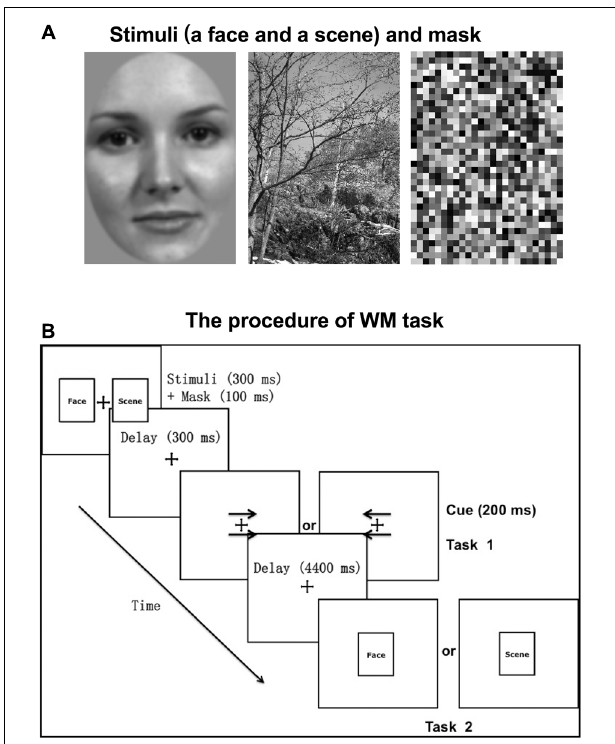
FIGURE 1 | Experimental stimuli and paradigm. (A) The stimuli (a face and a scene) and mask presented as an example. Stimuli consisted of grayscale images of 50 neutral faces (half male and half female) on a gray background and 50 natural scenes (3.2 ◦ horizontal and 4.5 ◦ vertical visual angles, respectively). (B) The procedure of WM task. Before the WM task (task 2), participants were required to complete a cue-responding task (task 1). The cue type (arrows pointing to right or left) and category of the probed target (face or scene) were counterbalanced across